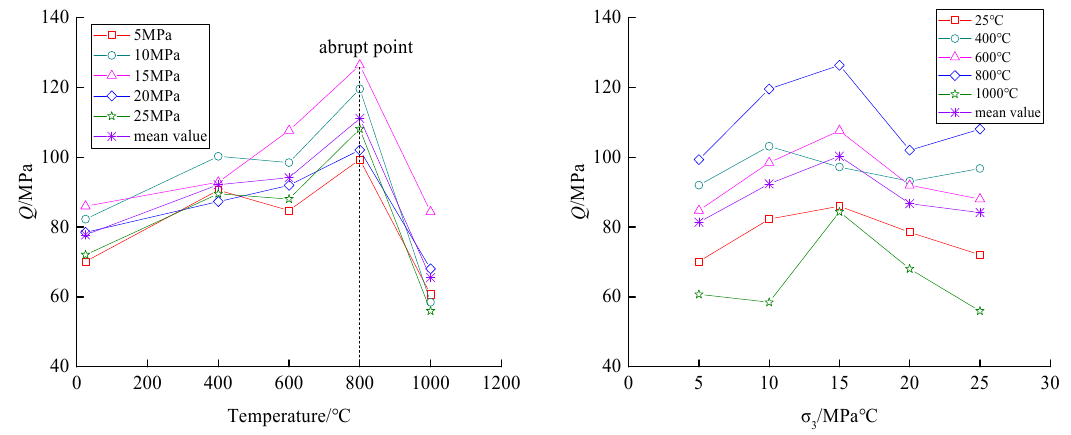
Figure 15. The relationship between the strength of material and temperature and confining pressure.